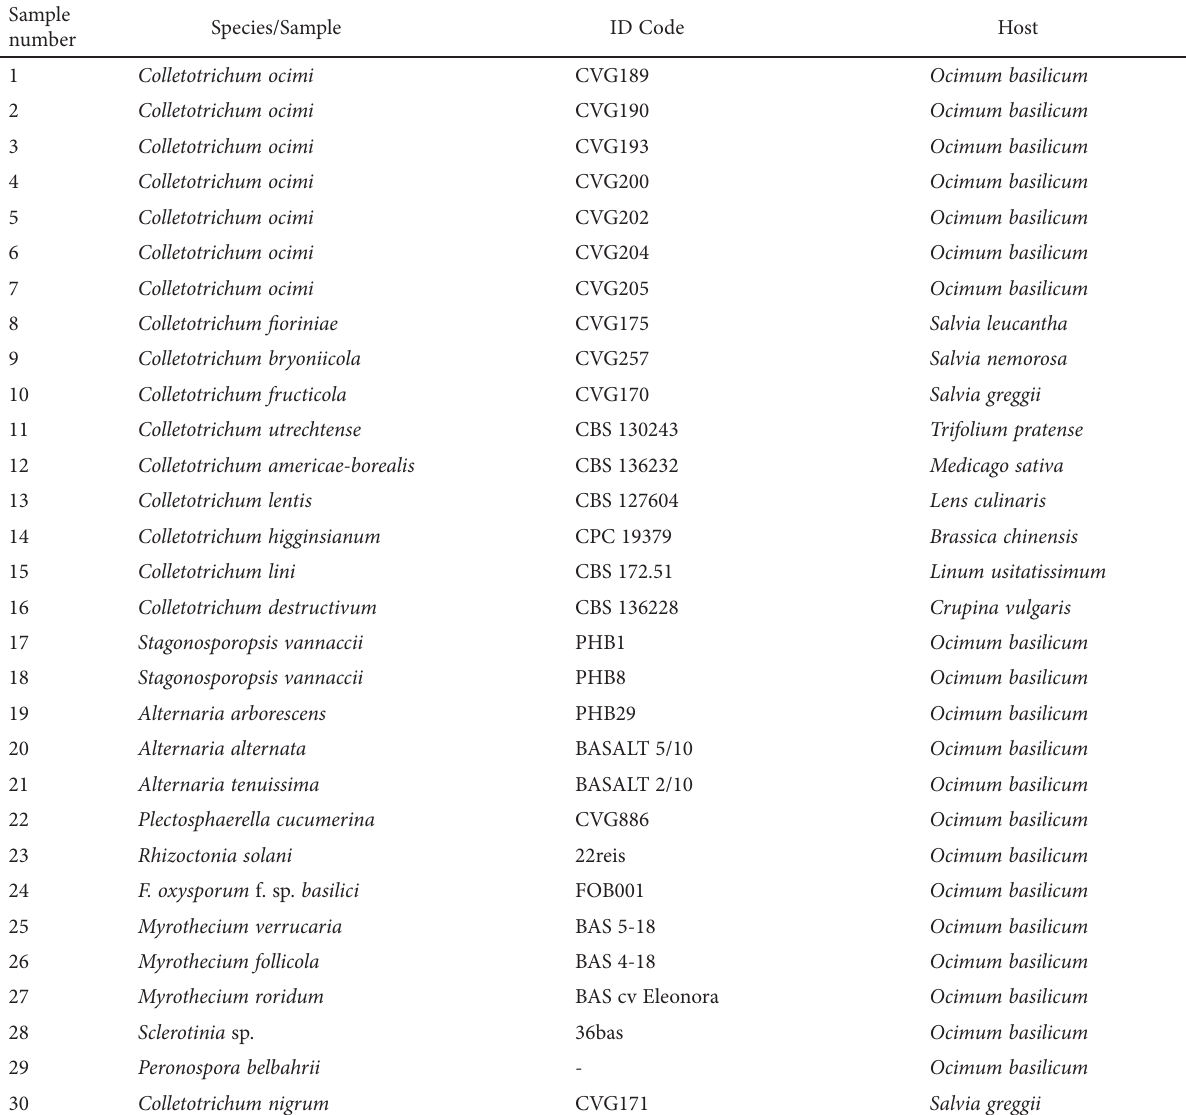
Table 1. List of isolates used in this study to assess the specificity of the primer pairs designed for the detection of Colletotrichum ocimi (TubOc_23fw - TubOc_190rev and TubOc68fw - TubOc_197rev).